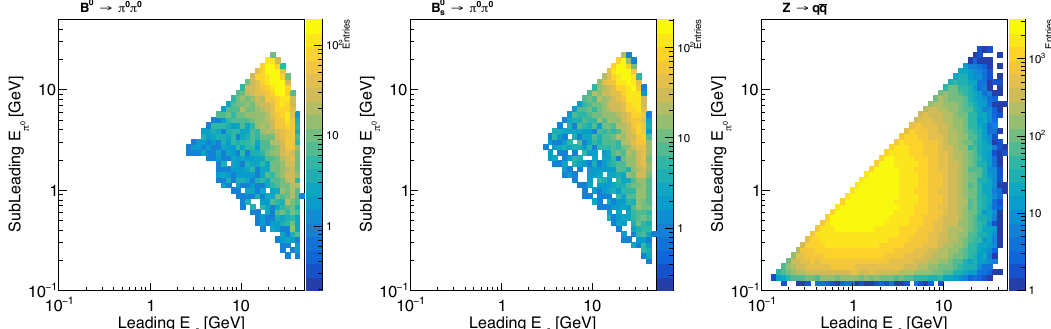
(a) 2D energy spectrum of π 0 pairs in B 0 → π 0 π 0 (left), B 0 (right) events.